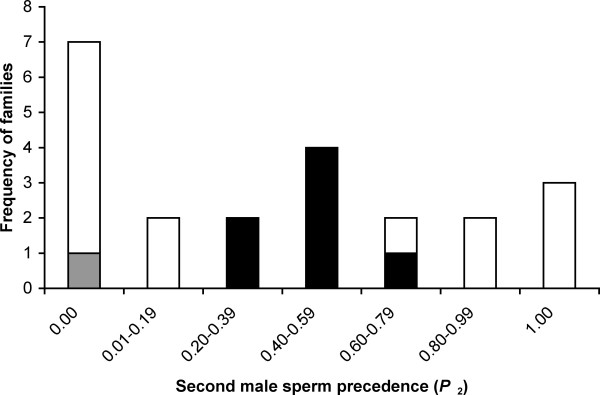
The distribution of second male sperm precedence (P2) among 22 dam-sire pair families in the stalk-eyed fly, Teleopsis dalmanni. Open bars depict the frequency of families with P2 significantly different from 0.5 (using 2-tailed binomial tests); black bars denote those with P2 not significantly different from 0.5. The grey bar denotes the sperm precedence of a single family where the observed P2 of zero was not significantly different from P2 = 0.5. However, the brood size of this family was small (n = 5), so this result should be treated with caution.